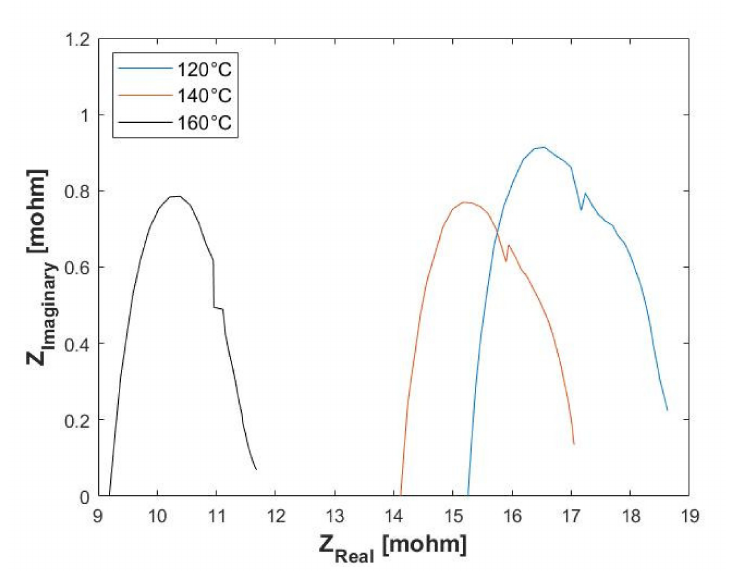
Figure 7. Electrochemical impedance spectroscopy (EIS) data showing the change in ohmic resistance (x-intercept) with temperature. Hydrogen flow rate = 100 mL n /min, 1